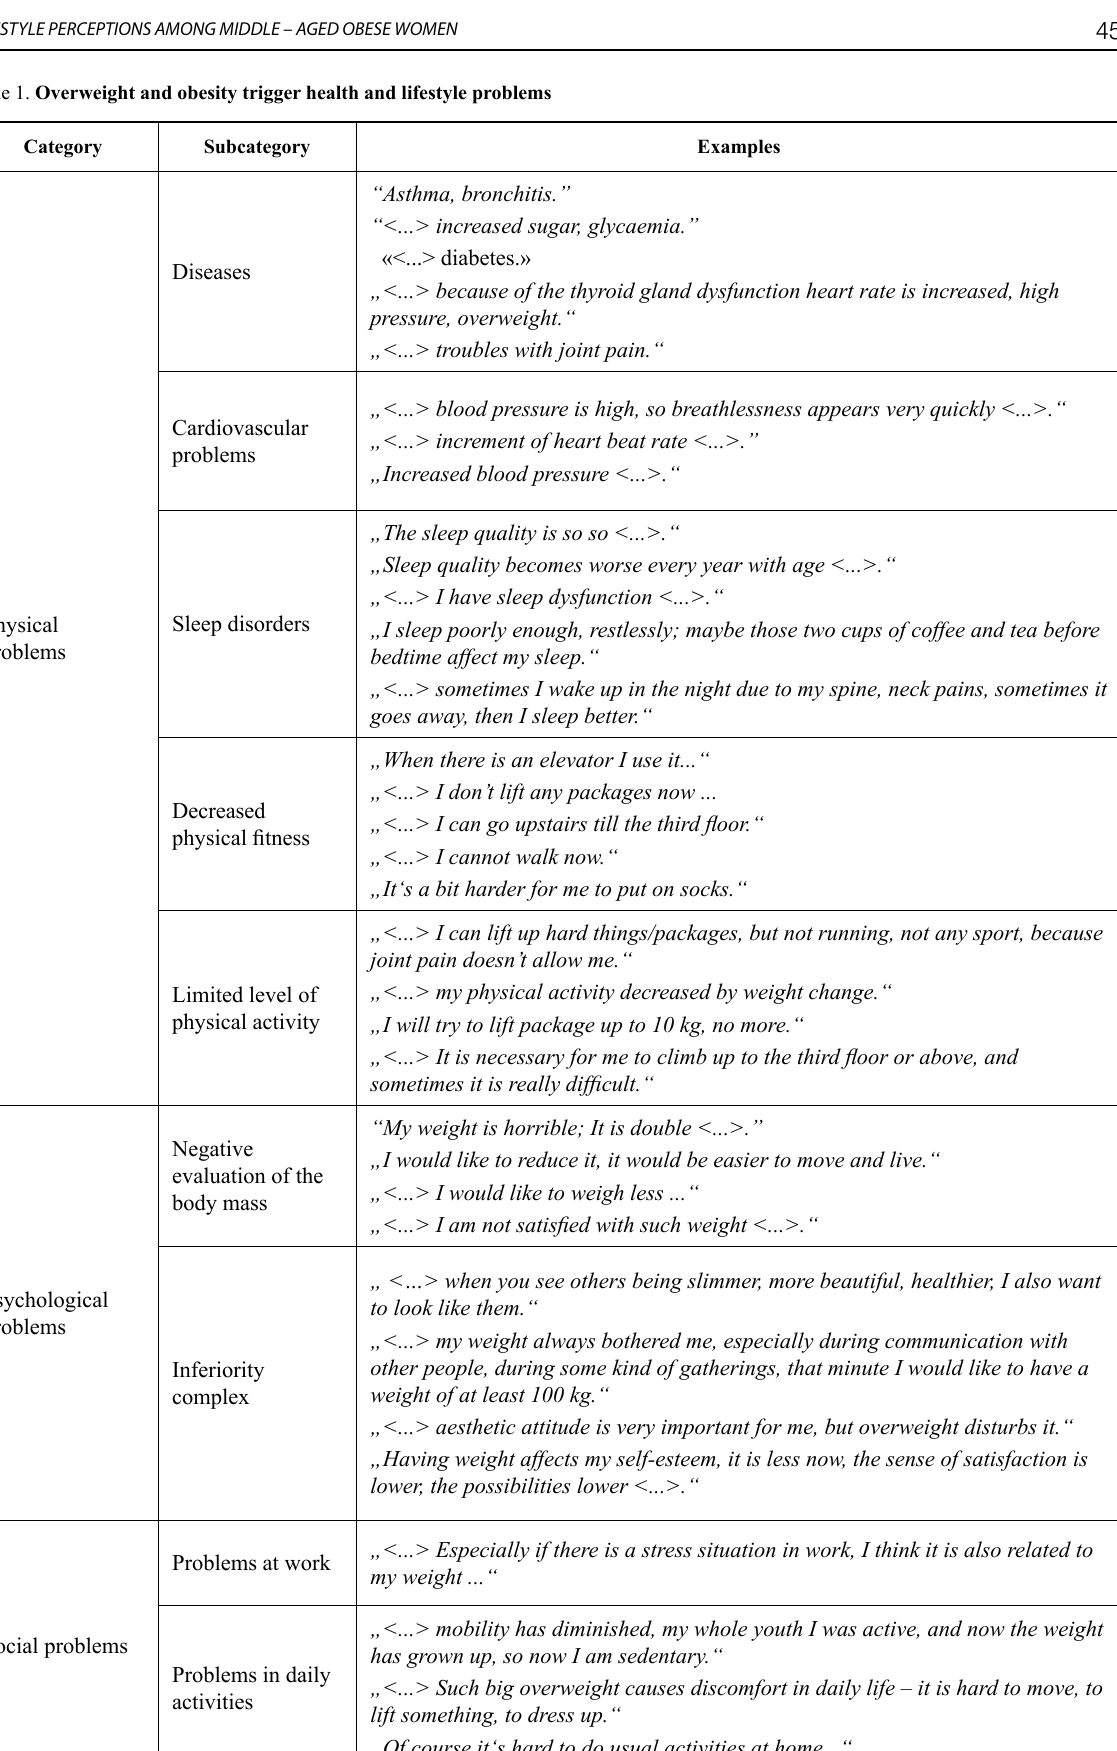
Table 1. Overweight and obesity trigger health and lifestyle